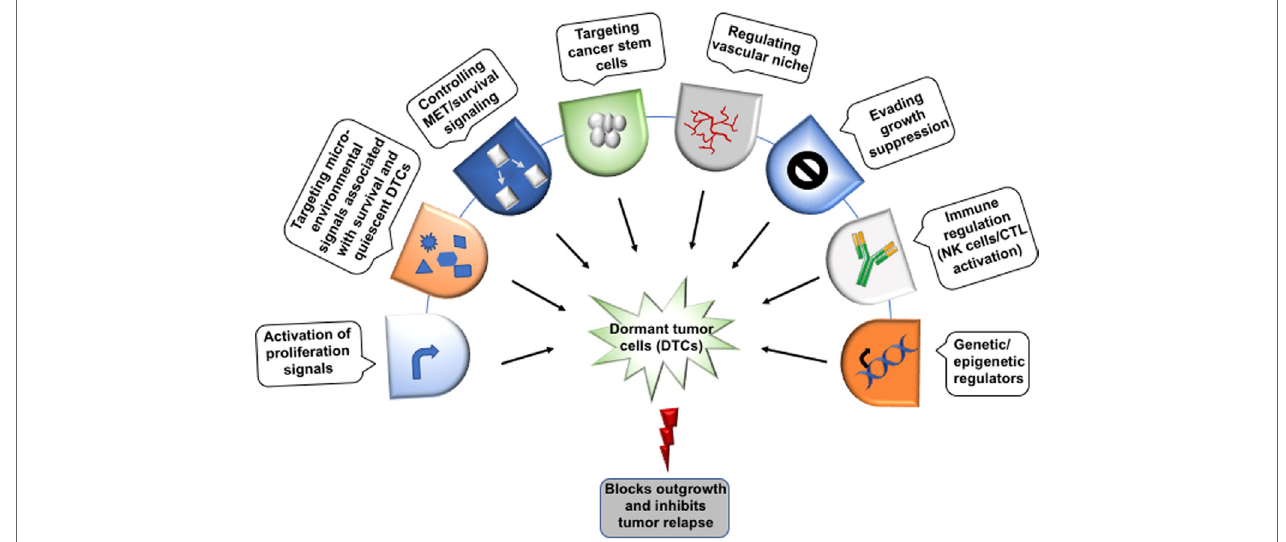
FiGURe 4 | Therapeutic implications of dormant tumor cells. The possible target sites to eliminate the dormant tumor cells (DTCs) in order to regulate metastatic relapse. Though the direct evidence to target the dormant cells yet needs to identify extensively. Moreover, the dormant cells can be targeted at several checkpoints including epigenetic regulators (DNMT1, EZH2), immune cells (NK cells/CTL) activation, evading growth suppression, vascular niche, quiescent cancer stem cells, survival signaling, and the microenvironment signals (bone morphogenetic protein 4/7, CXCL12, TRAIL, growth arrest-specific 6, TGF β -2, BME, and thrombospondin 1) that help in the maintenance of the dormant